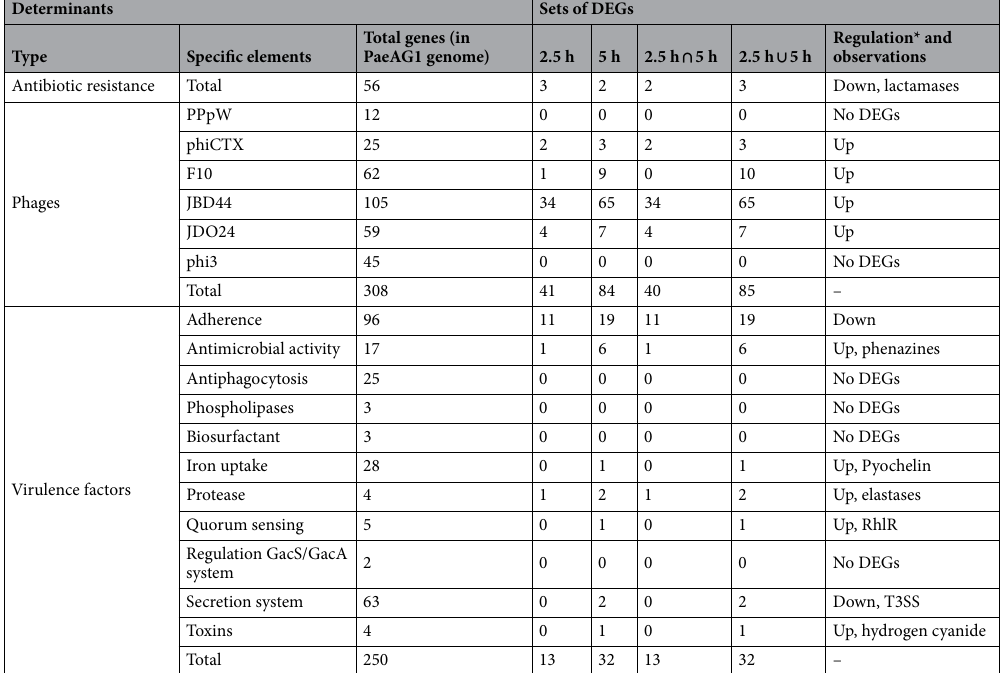
Table 2. Comparison of DEGs of PaeAG1 at 2.5 and 5 h after treatment with ciprofloxacin, and specific phages or categories of virulence factors, including shared genes (intersection) and total genes at both times (union), the regulation and the type of elements. *Based in logFC of genes for both times 2.5 and 5 h. Type of elements is also